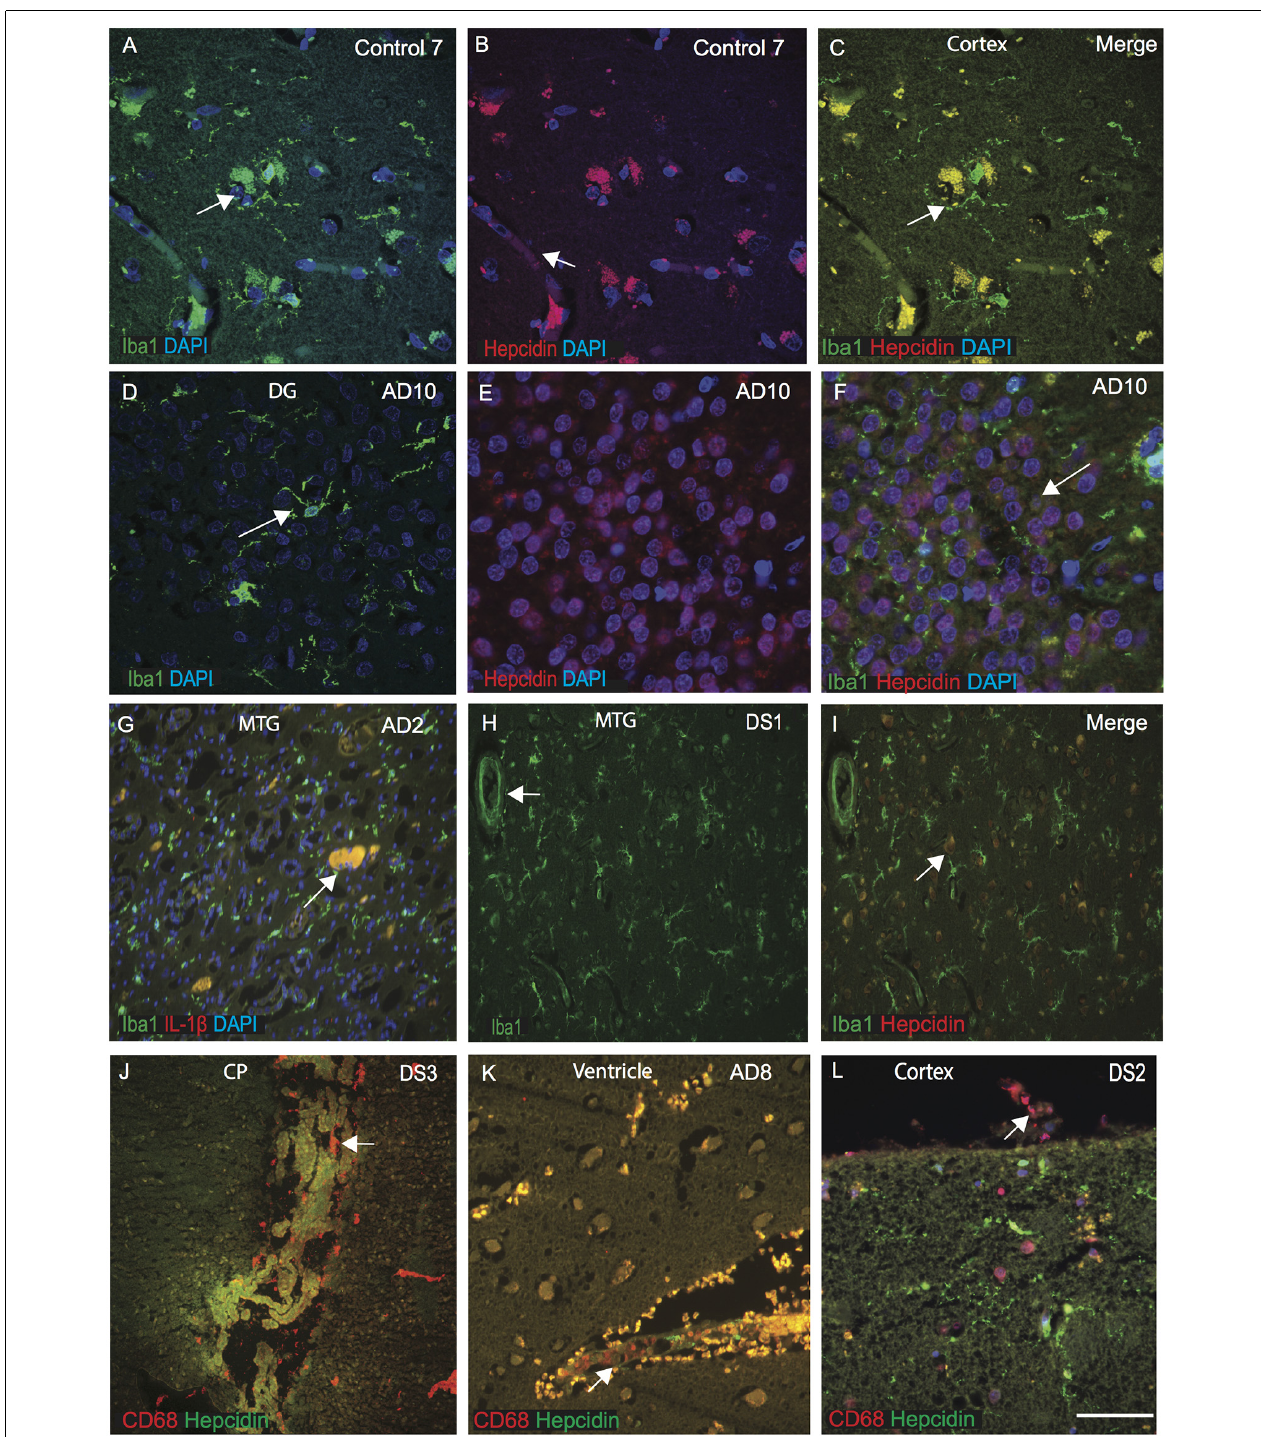
FIGURE 4 | Selective population of microglia and meningeal macrophages are involved in brain iron homeostasis in DS. The brain sections from controls, AD, and DS subjects were labeled with hepcidin and microglial marker (Iba1) or macrophages marker CD68, and counterstained with DAPI for nuclei (blue). Hepcidin was seen in the vesicles, most probably entering from blood vessels and IbaI positive ramified microglia, colocalized in the control cortex (A–C) . In AD brain dentate gyrus (DG), showing IbaI positive activated microglia (D) , whereas hepcidin was present in the DG granule cells not in the damaged microglia (E) with no visible co-localization (F) . Iba1 positive microglia may be involved in pruning and clearance of damage cells, where hepcidin protect the granule cells from further damage (F) . Brain section from AD (MTG) stained with Iba1 and pro-inflammatory marker IL-1 β showing both proteins to be co-localized in the small plaques and